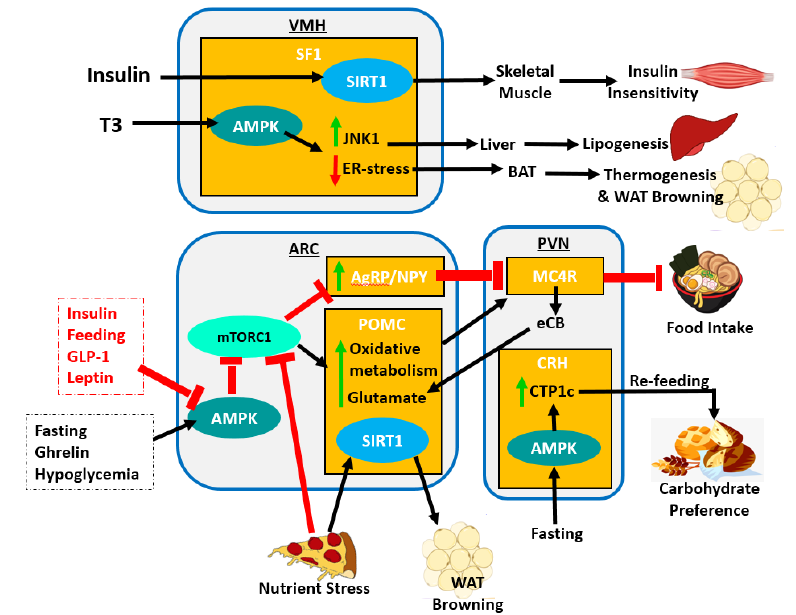
Figure 4. Organism-wide interactions with hypothalamic nuclei alter metabolism and energy homeostasis. AMPK activity is inversely affected by fasting, ghrelin and hypoglycemia compared to insulin, feeding, GLP-1 and leptin. Inhibition of mTORC1 by AMPK increases Agrp, in turn inhibiting MC4R neurons, and promoting energy intake. Alternately, inhibition of AMPK allows mTORC1 activity, which promotes pomc expression, oxidative metabolism, and an increase in activation of the MC4R-PVN neurons that signal satiety. In addition, the activation of MC4R neurons stimulates production of eCB, which feedback to POMC neurons to increase glutamate production, thereby increasing glutamatergic POMC neuronal input to the PVN. Nutrient stress is also a strong inhibitor of mTORC1 activity and a stimulator of SIRT1 expression in POMC-ARC neurons, whose downstream projections initiate WAT browning. Fasting results in AMPK activity in CRH-PVN neurons, resulting in a carbohydrate preference during re-feeding. Other nutrient signals such as insulin also stimulate the SF1-VMH neurons to express SIRT1 that increases insulin insensitivity in skeletal muscle. The thyroid hormone, T3 elicits AMPK activity in the SF1-VMH neurons and through a dual pathway that increases JNK1 and decreases ER stress to produce hepatic lipogenesis and BAT thermogenesis/WAT browning, respectively.